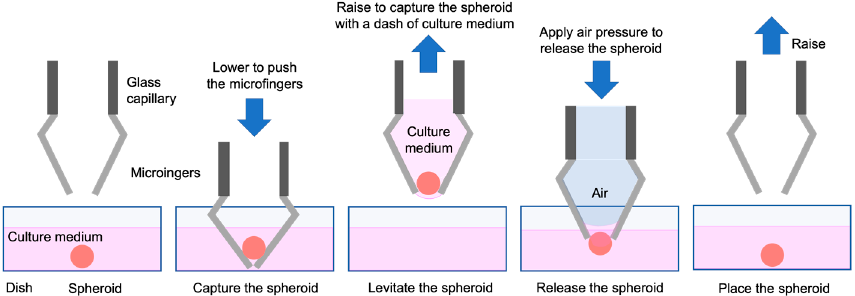
Figure 8. Handling procedure of a spheroid using microfingers mounted on a glass capillary.